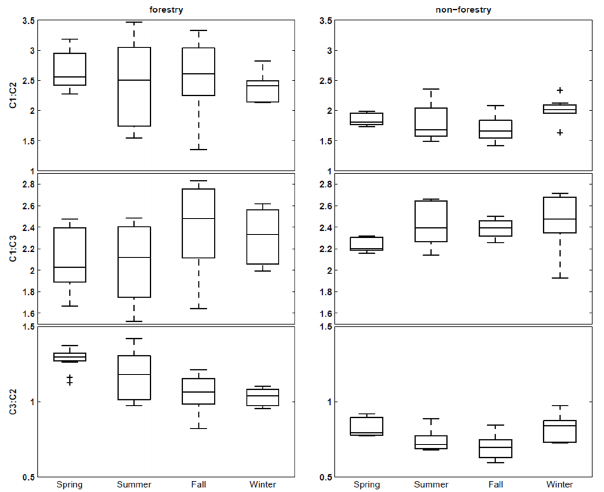
Figure 6 Fig. 6. Boxplots of seasonal changes of the DOM composition ex- pressed as changes in the component ratios and sorted for the differ- ent land-use types (forestry versus non-forestry streams). Boxplots are based on single values ( n = 98).